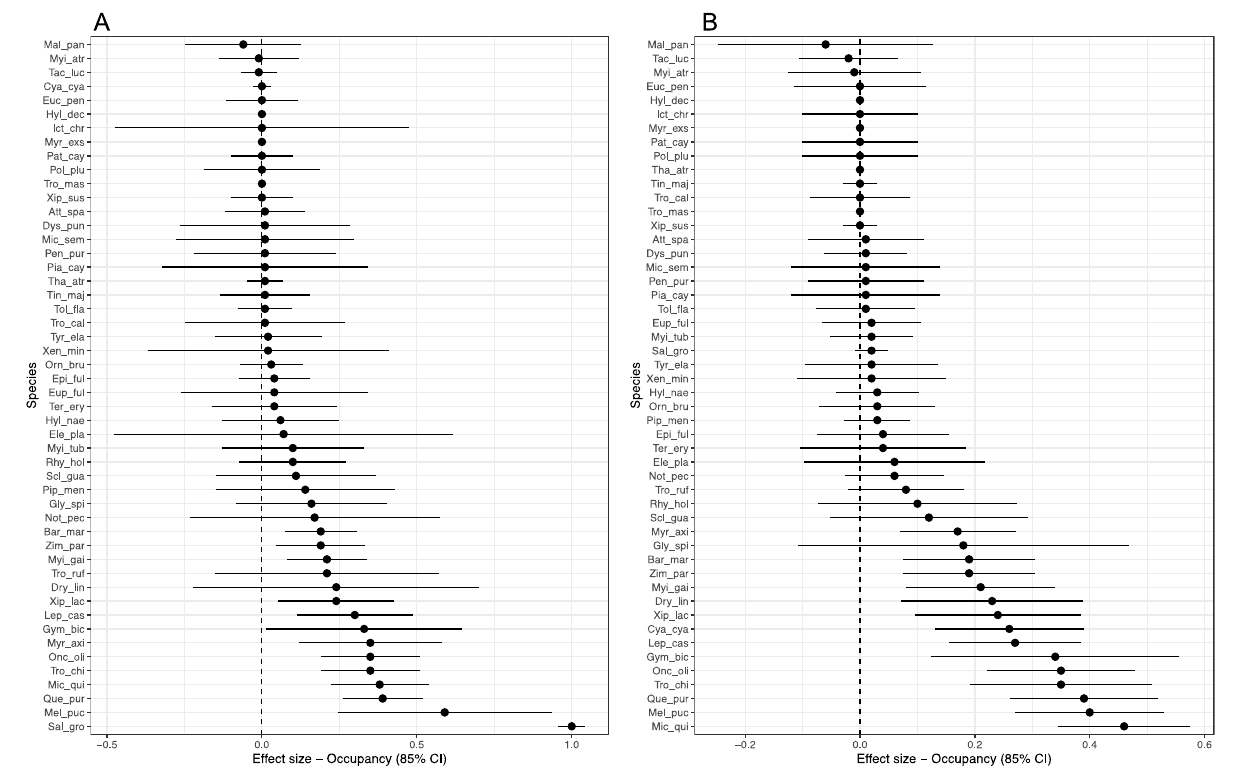
Figure 4. Model-averaged estimates of effect sizes of Forest Age on bird occupancy in ( A ) the historical era and ( B ) current era. Error bars are 85% confidence intervals. The dot line represents no change in occupancy between old-growth and secondary forest; species to the left of the line had higher occupancy in the secondary forest, whereas species to the right of the line had higher occupancy in old-growth forest. For more information on species code and names, see Table S1.